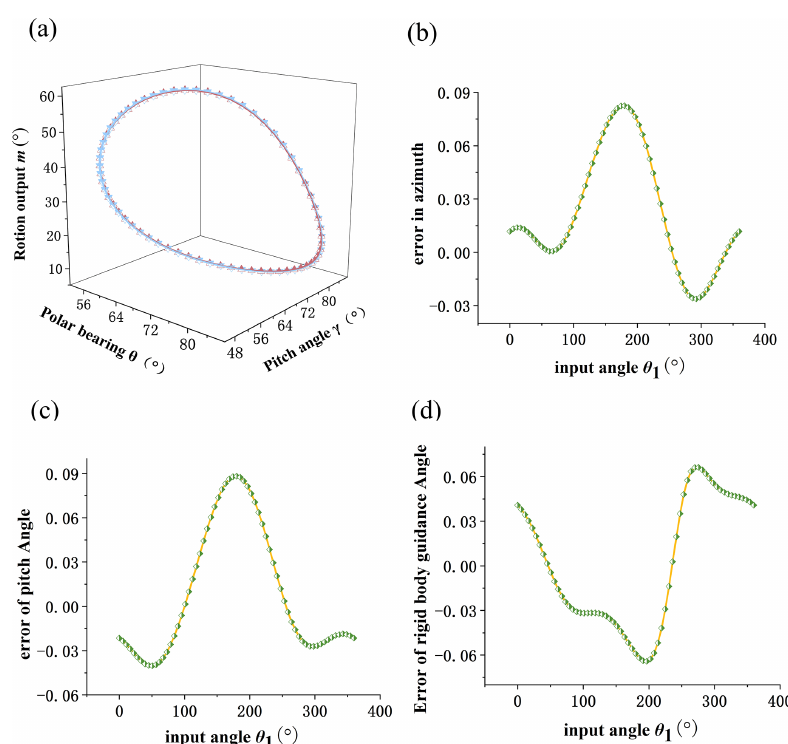
Figure 12. Comparison drawing of the second group of